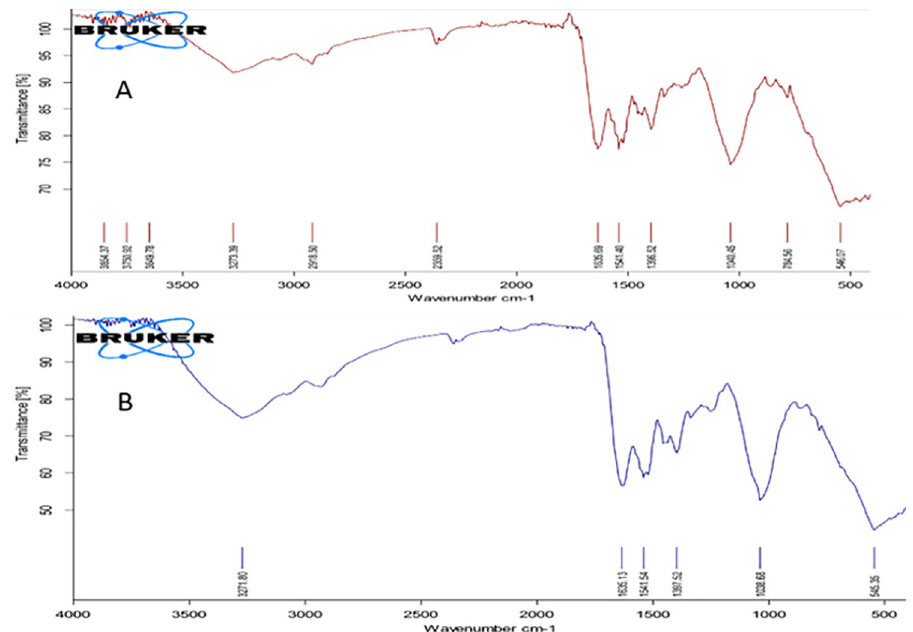
Fig 2. FTIR spectra of Acacia arabica extract (A) green synthesized ZnO NPs by Acacia arabica extract (B).